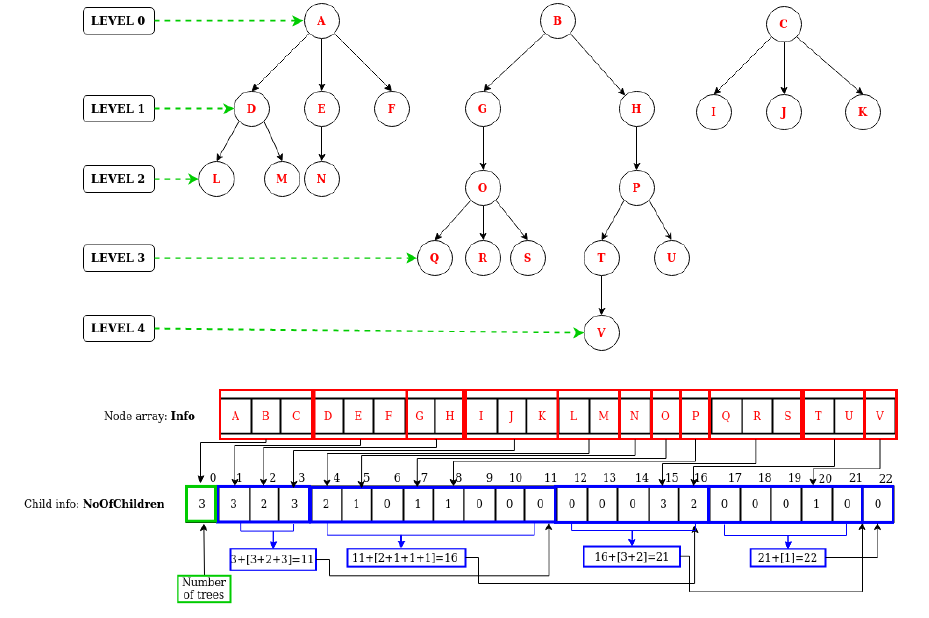
Figure 1. Forest Data Structure